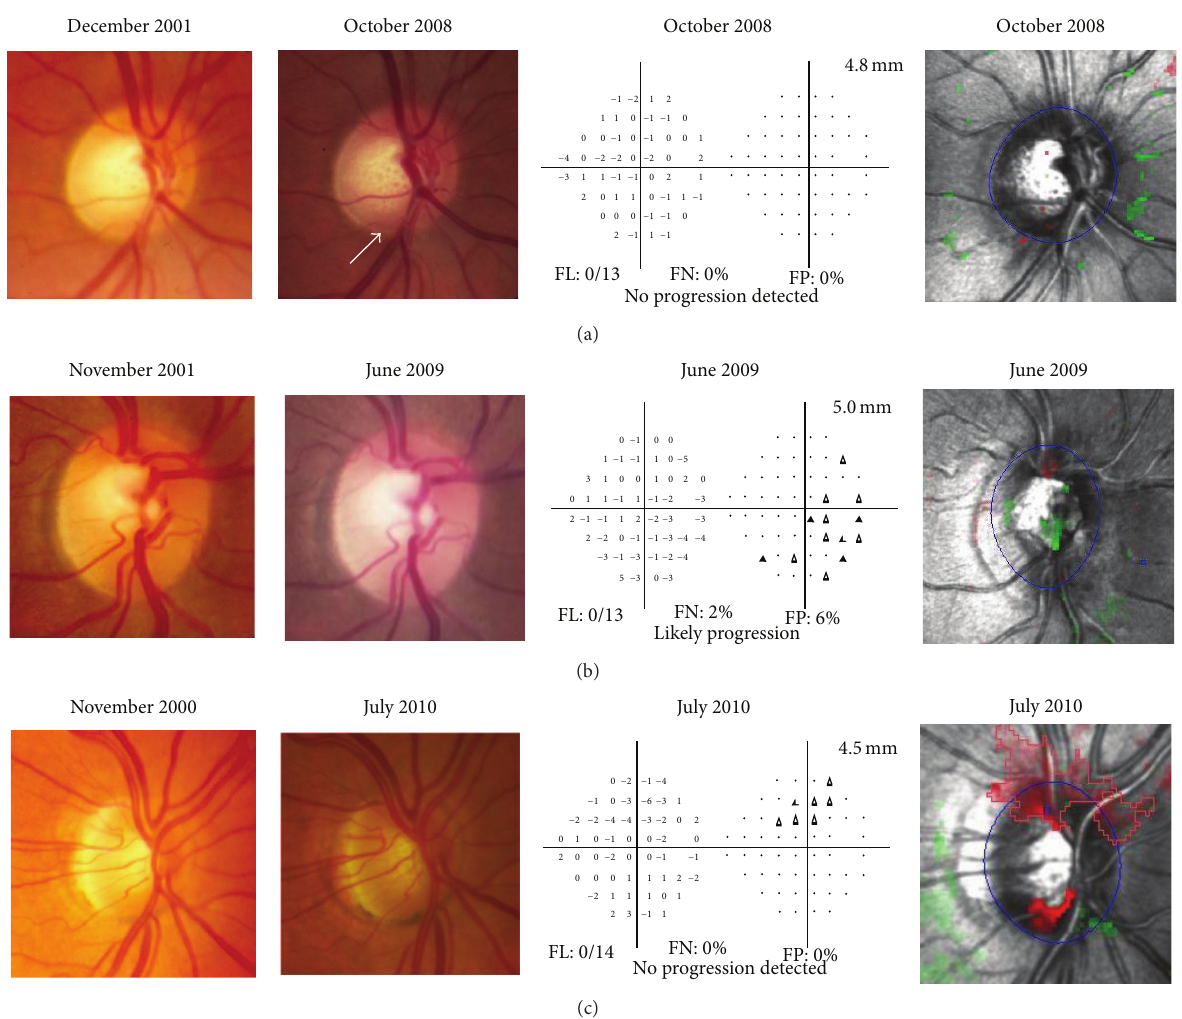
Figure 4: Case examples of disagreement for detecting glaucoma progression among Topographic Change Analysis (TCA) map, optic nerve head (ONH) stereophotographs (SPGs), and Visual Fields (VFs). (a) Low tension glaucoma (LTG), OD, female. This eye was TCA-stable at recruitment (2001). During the prospective followup it remained stable on both TCA and VF. Progression was found only on SPG (increased cupping and inferior rim thinning). (b) Primary open angle glaucoma (POAG), OD, female. This eye was TCA-stable at recruitment (2001). During the prospective followup it remained stable on both TCA and SPG. Progression was found only on VF. (c) POAG, OD, female. This eye was TCA-progressed at recruitment (2000). During the prospective followup it remained stable on both VF and SPG. TCA showed progression (superior and inferior rim thinning) throughout the study